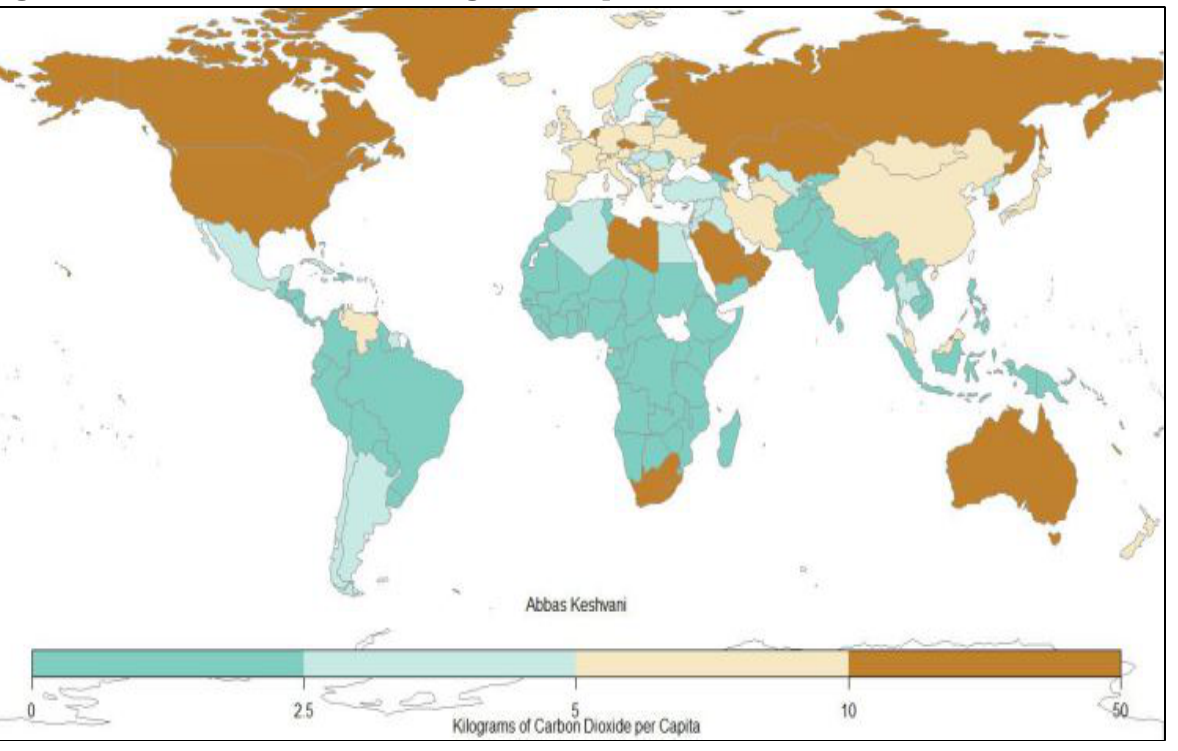
Source: Carle 2015. Figure 2: Who caused climate change? Per capita emissions